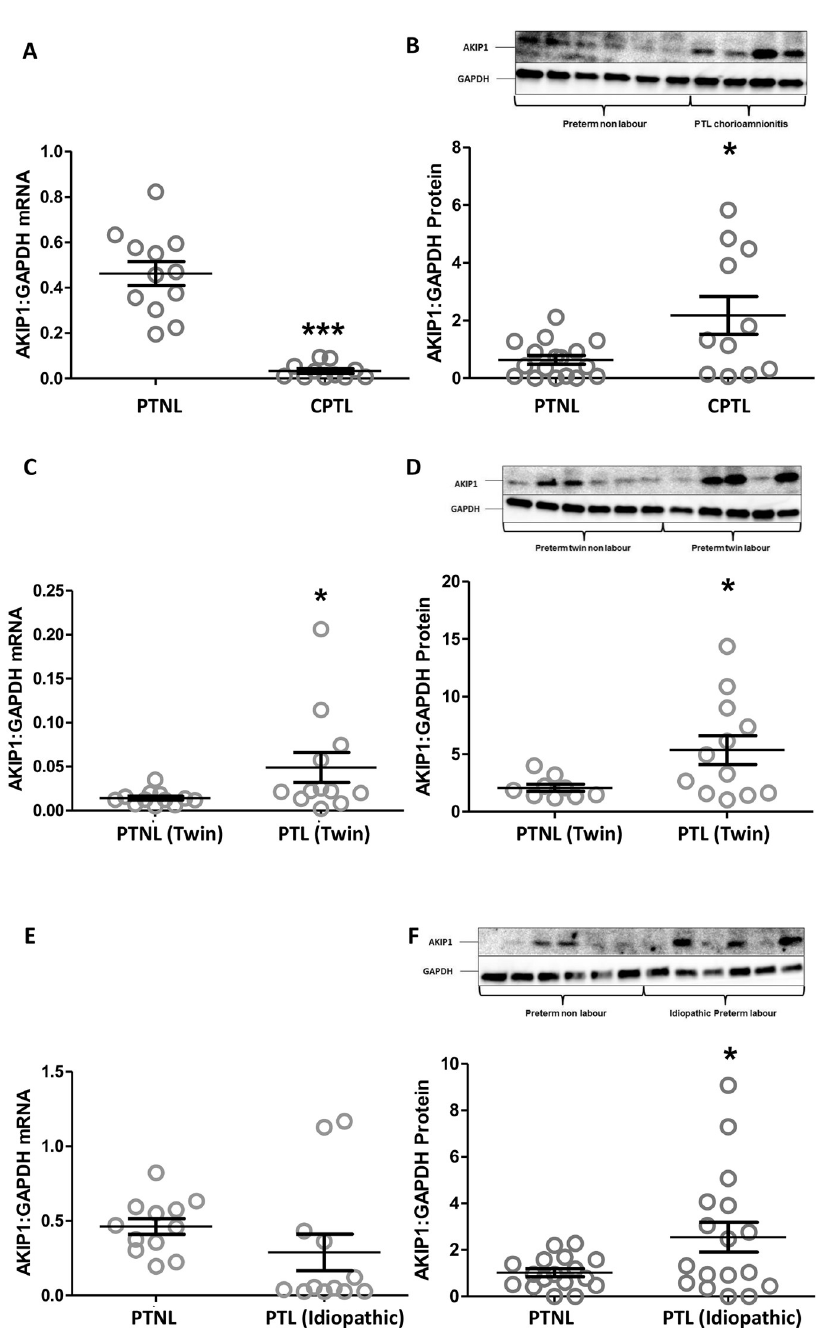
Fig 5. The effect of inflammation and stretch on AKIP1 expression. Human myometrial tissue samples were collected from different groups of non-labouring and labouring women at the time of Caesarean section. Women were recruited in four defined groups: preterm not in labour (PTNL), preterm in labour due to chorioamnionitis (A and B), tweens (C and D) and idiopathic preterm labour (E and F) as stated in Materials and Methods. Samples were snap frozen at -80˚C for mRNA and protein extraction. The levels of AKIP1 mRNA (A, C and E), and AKIP1 (B, D and F) proteins were measured using rt-PCR and western blotting respectively. A representative western blot is shown above each protein graph displaying the densitometry of the protein levels. Blots were probed with AKIP1, and GAPDH was used as a loading control. Data are shown as the mean, and SEM ( � P < 0.05, �� P < 0.01), n = 11–17 in each group.